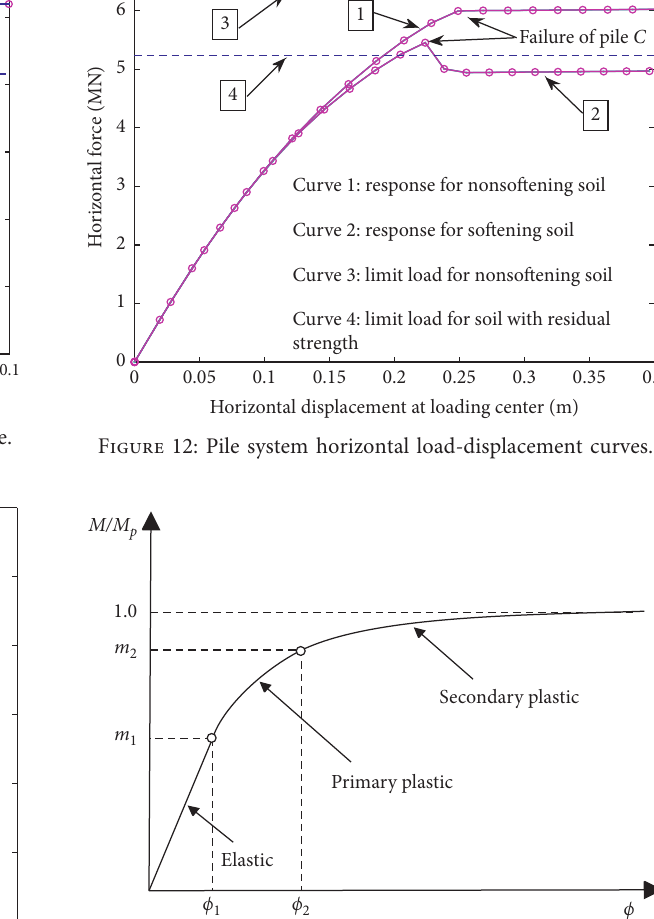
Figure 13: Representation of moment-thrust-curvature